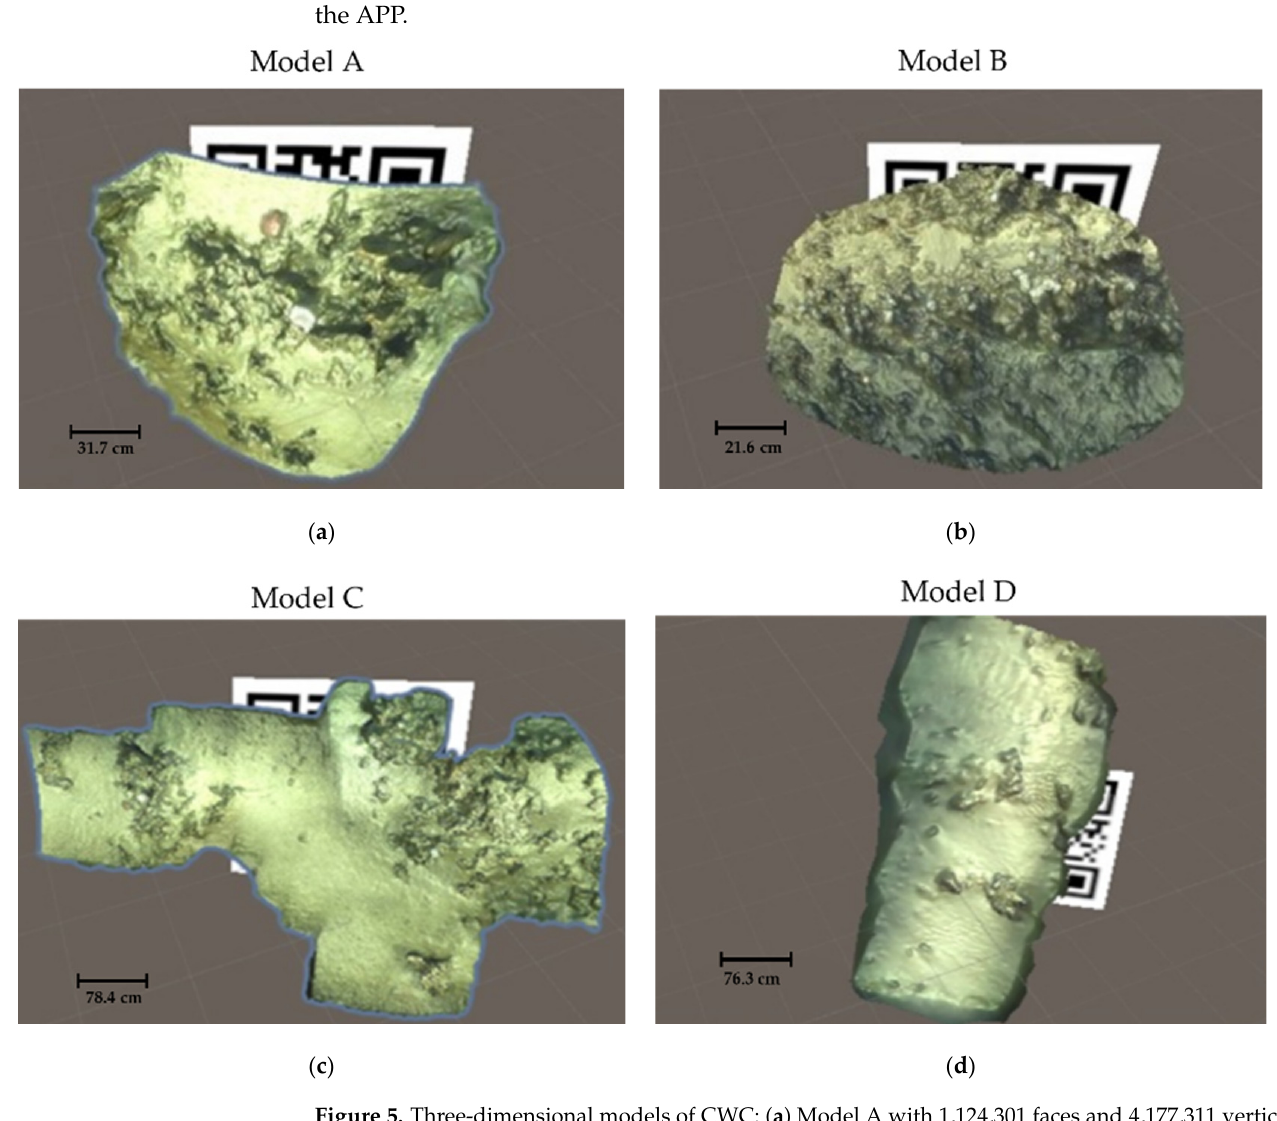
Figure 5. Three-dimensional models of CWC: ( a ) Model A with 1,124,301 faces and 4,177,311 vertices at a resolution of 297,749.21 faces/area (m 2 ); ( b ) Model B with 462,589 faces and 232,453 vertices at a resolution of 31,825.87 faces/area (m 2 ); ( c ) Model C with 6,285,480 faces and 3,154,610 vertices at 292,660.99 faces/area (m 2 ); ( d ) Model D with 44,000 faces and 22,122 vertices at 4108.31 faces/area (m 2 ), with A extracted from C.